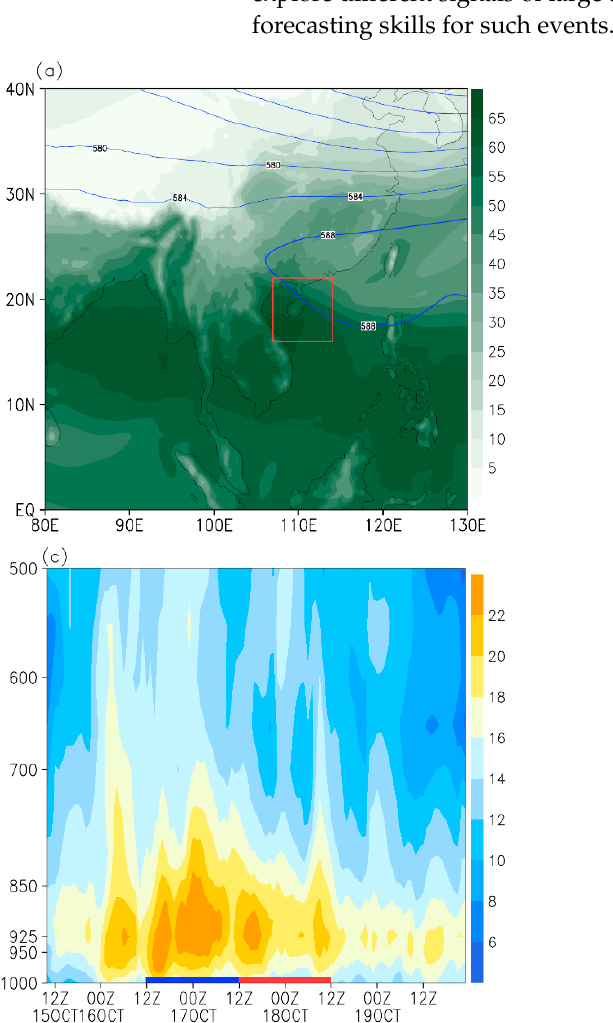
Figure 1. ( a ) ERA5 reanalysis of the 500-hPa geopotential height (contours, units: dagpm) and precipitable water (shading, units: mm) averaged over 144 h from 0000 UTC 14 to 2300 UTC 19, with the red box indicating the domain for ( d ). ( b ) 925-hPa stream field and equivalent potential temperature (shading, units: K), and horizontal wind with speed above 16 m s − 1 (a full bar represents 4 m s − 1 ) at 0400 UTC 18. ( c ) Time series of horizontal wind speed (unit: m s − 1 ) from 1200 UTC 15 to 0000 UTC 20 October at (110.5° E, 18.5° N), with blue and red bars at the bottom indicating early and later stages respectively. ( d ) Observed 60-h accumulated precipitation (color dots, units: mm) ending 1200 UTC 18 October, topography of Hainan Island (shading, units: m) with green and blue triangles denoting the locations of Wanning and Sanya, green and blue rectangles denoting the southeast and south coasts respectively, and red pins denoting locations of Doppler radar stations as listed in Table 1.